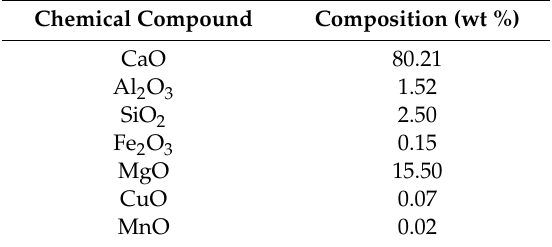
Table 1. Chemical composition of dolomite.